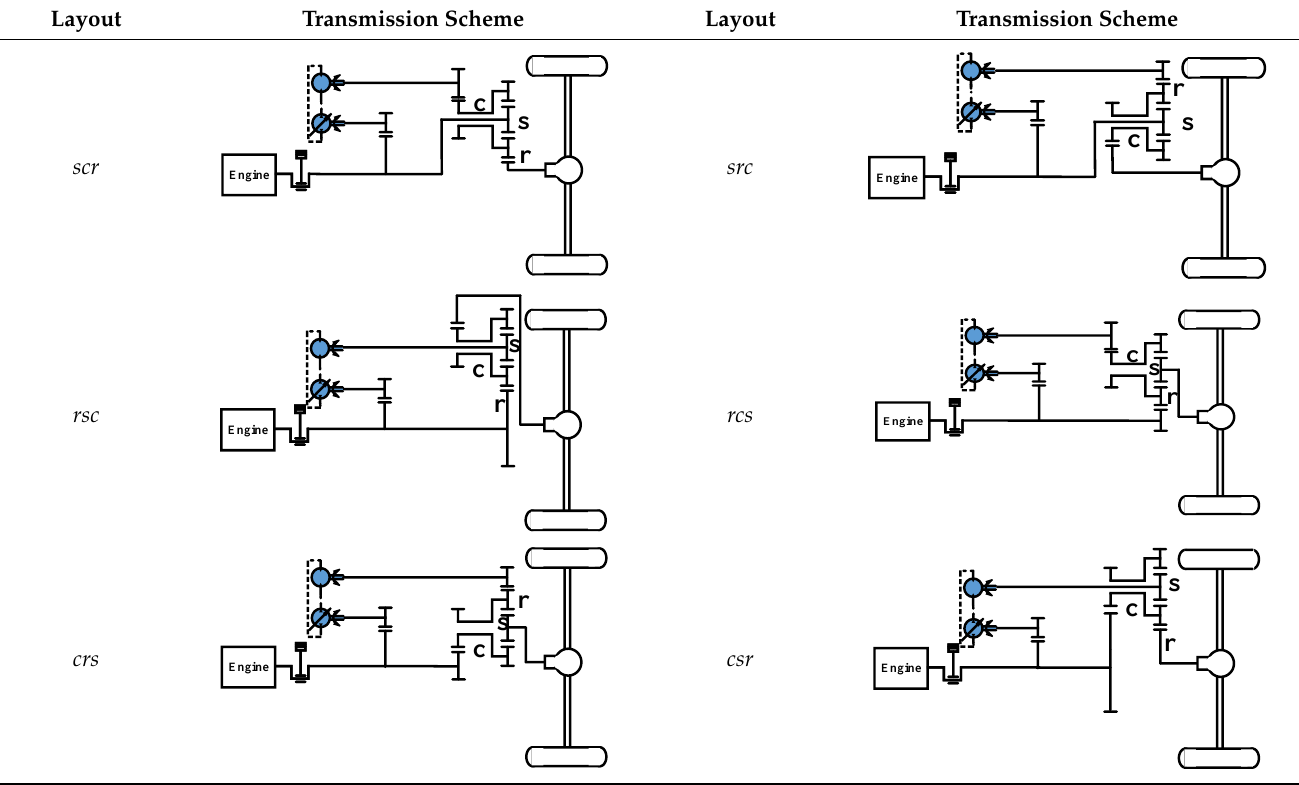
Table 3. Transmission schemes with different layouts.